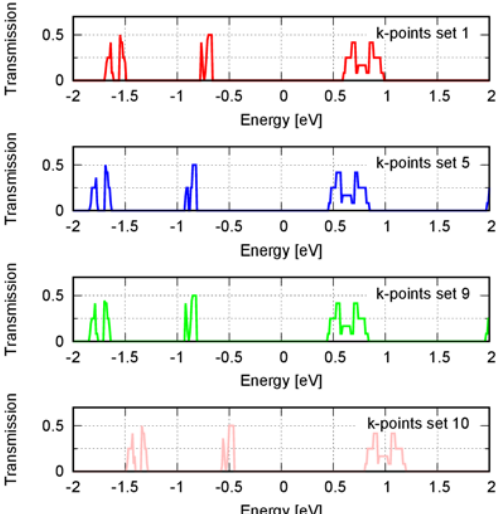
Figure 3. Electronic transmission spectrum along the transport direction P1 for compound 1 using a band structure calculated with different k-point numbers. Sets 1, 5, 9, and 10 corresponded to the k-point densities of ~9, 52, 110, and 116 Å, respectively. The transmission spectrum along the other directions is shown in Figure S3 of the Supplementary Materials. The energy was relative to the Fermi level, which was set to zero.